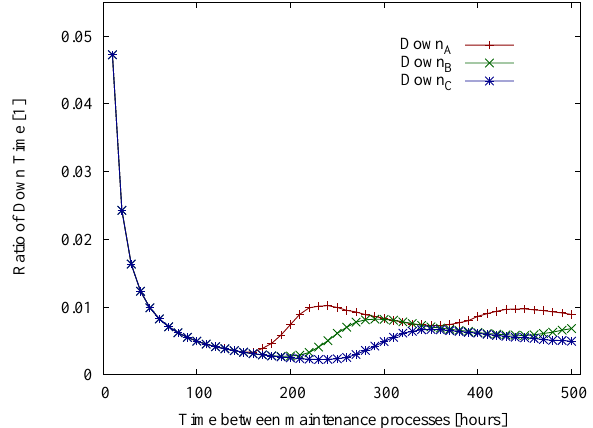
Figure 4: The ratio of down time as a function of time between maintenance processes.